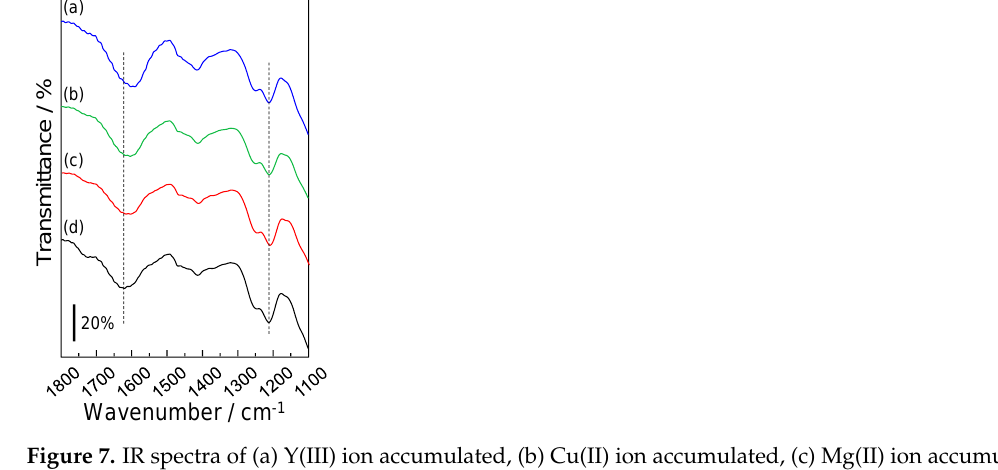
Figure 7. IR spectra of (a) Y(III) ion accumulated, (b) Cu(II) ion accumulated, (c) Mg(II) ion accumu- lated, and (d) non-accumulated F-20 wt% SiNSi composite materials. Triplicate experiments gave similar results.